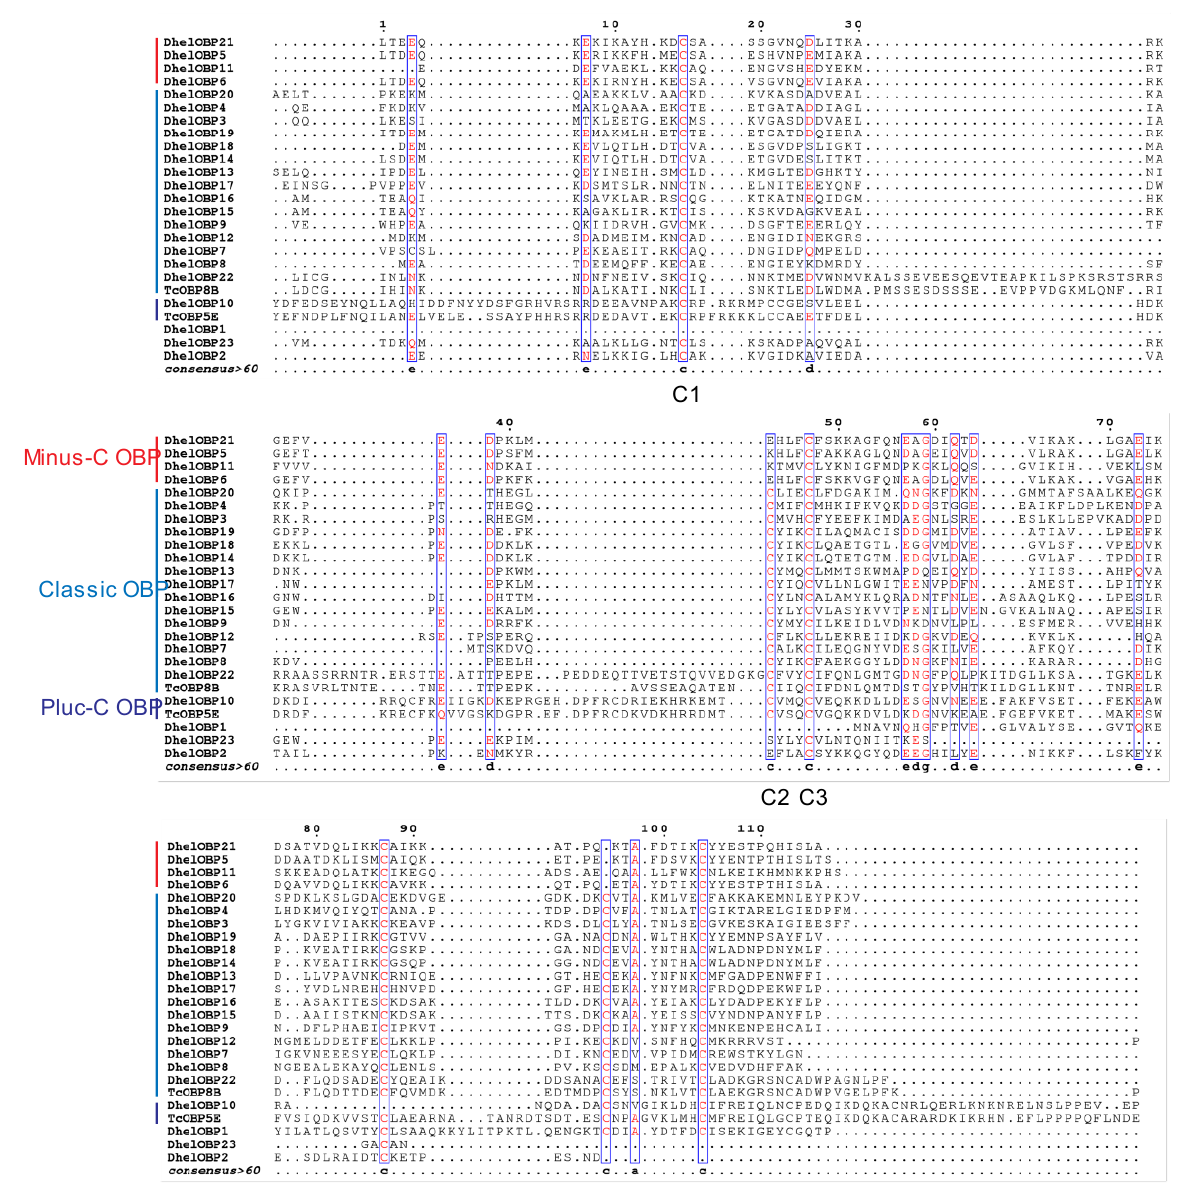
Figure 2. Multiple sequence alignment of OBPs from Dastarcus helophoroides and Tribolium castaneum . The complete alignment results were presented in Figure S1. Conserved cystine was annotated according to the classic OBP subfamily.